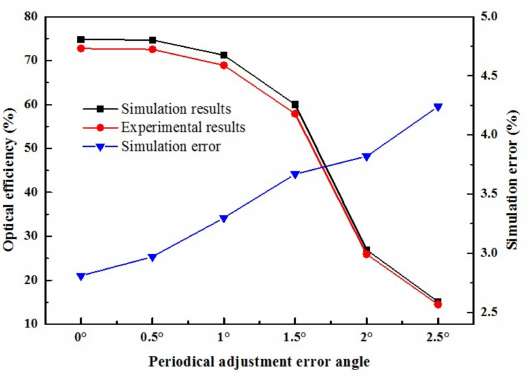
Figure 13. The optical efficiency and the simulation error for various periodical adjustment error angles.